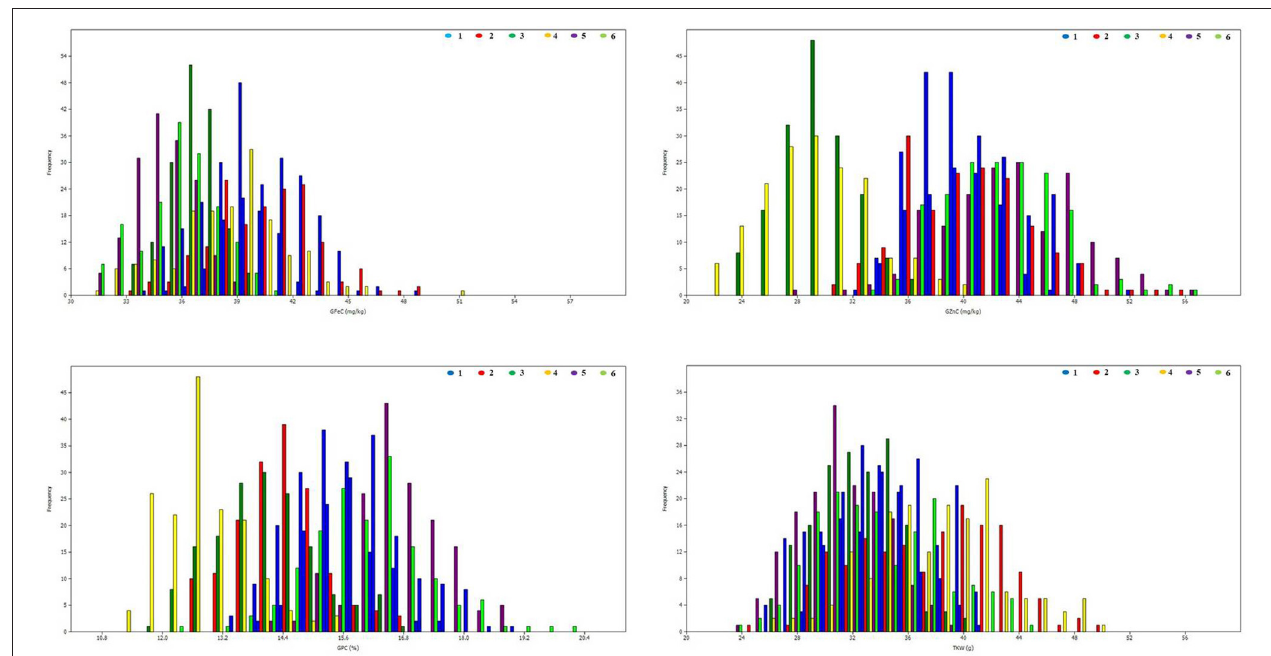
FIGURE 2 | Frequency distributions for grain iron, zinc, protein, and thousand kernel weight in RIL population grown across three locations for 2 years. 1: ICAR-IARI_2012–13; 2: ICAR-IARI_2013–14; 3: GBPUA&T_2012–13; 4: GBPUA&T_2013–14: 5: Pusa Bihar_2012–13; 6: Pusa Bihar_2013–14.